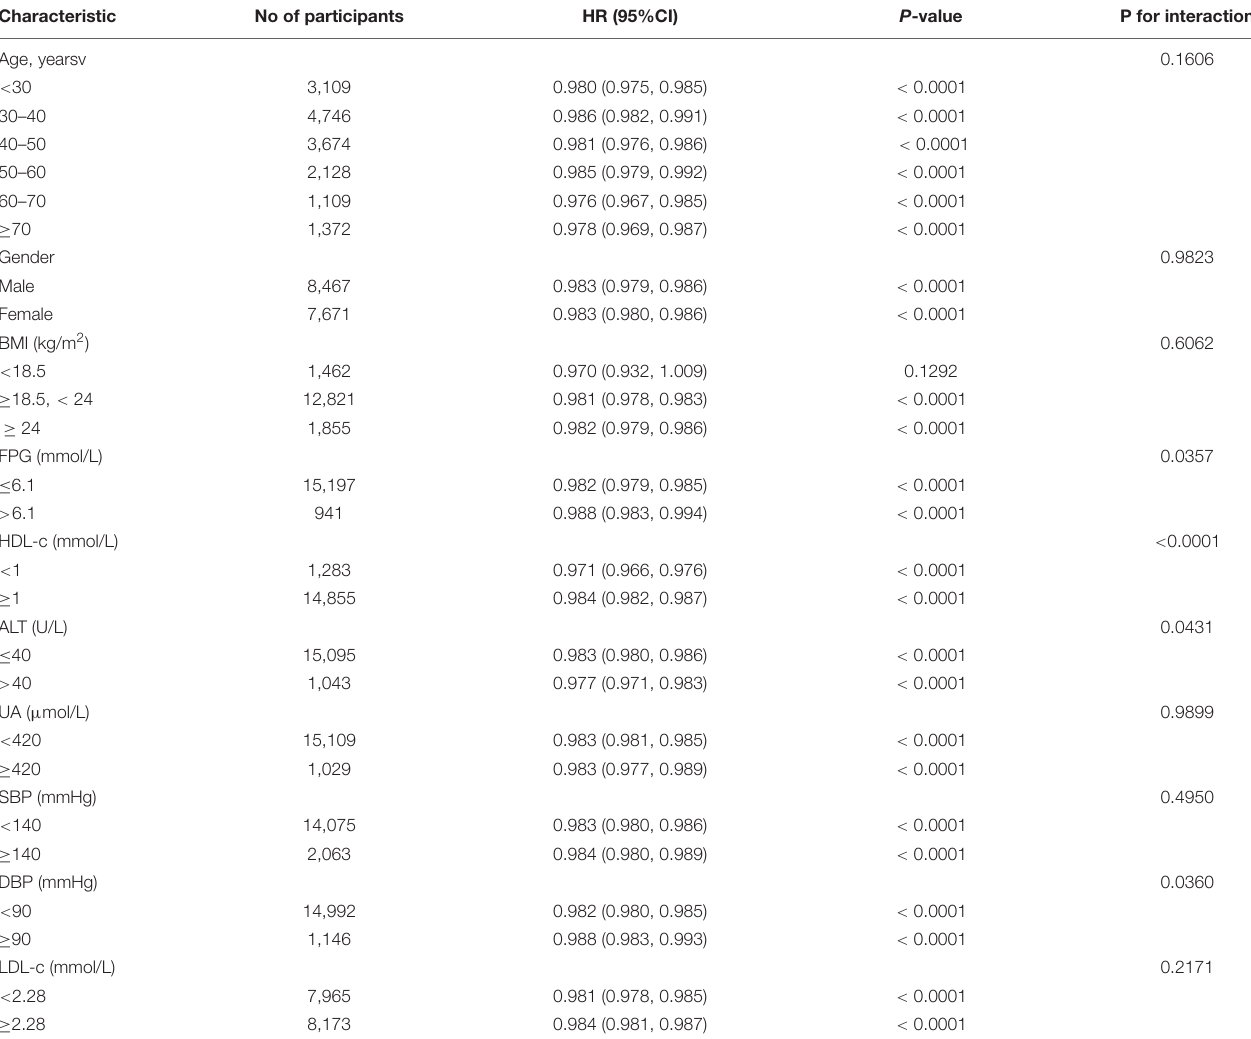
TABLE 7 | Effect size of eGFR on NAFLD in prespecified and exploratory subgroups. Characteristic No of participants HR (95%CI) P -value P for